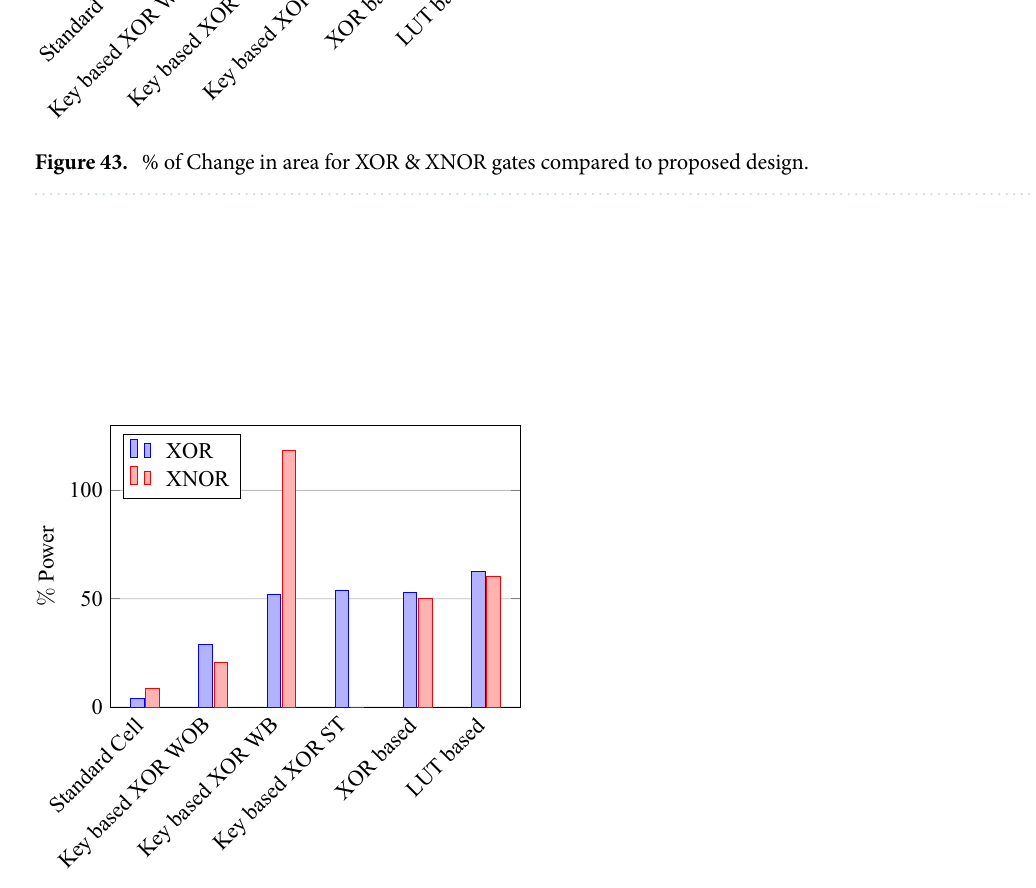
Figure 44. % of Change in power for XOR & XNOR gates compared to proposed